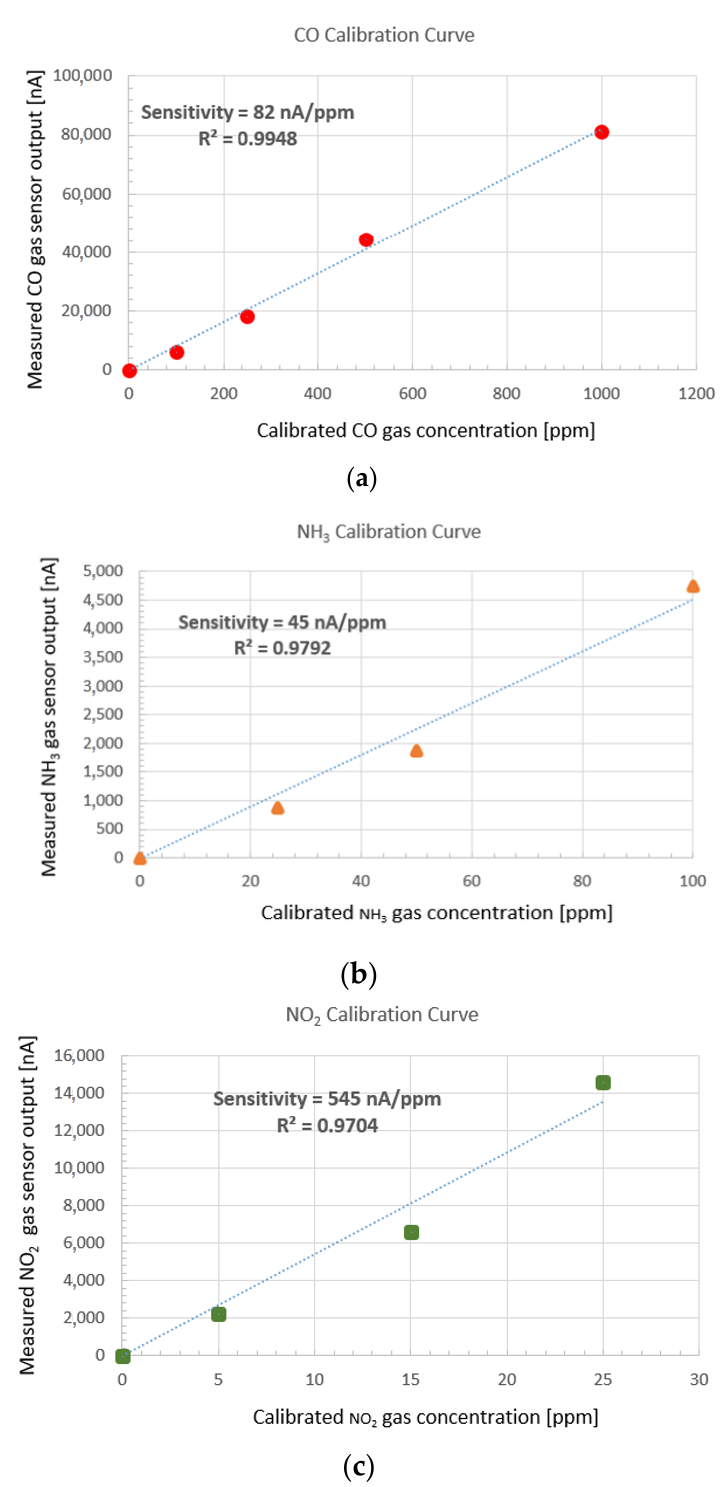
Figure 3. Gas calibration curves. ( a ) CO gas standard vs. CO sensor; ( b ) NH 3 gas standard vs. NH 3 sensor; ( c ) NO 2 gas standard vs. NO 2 sensor.